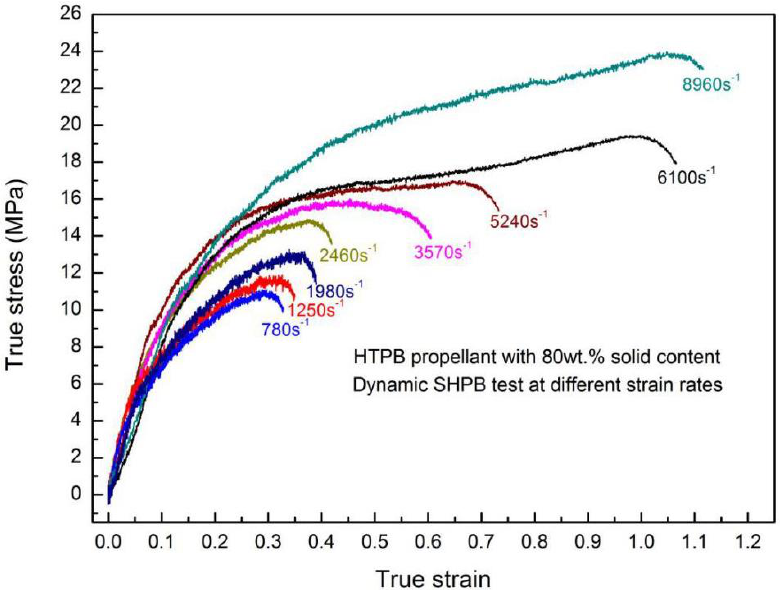
Figure 10. True stress–strain plots of H-80W under various strain rates.